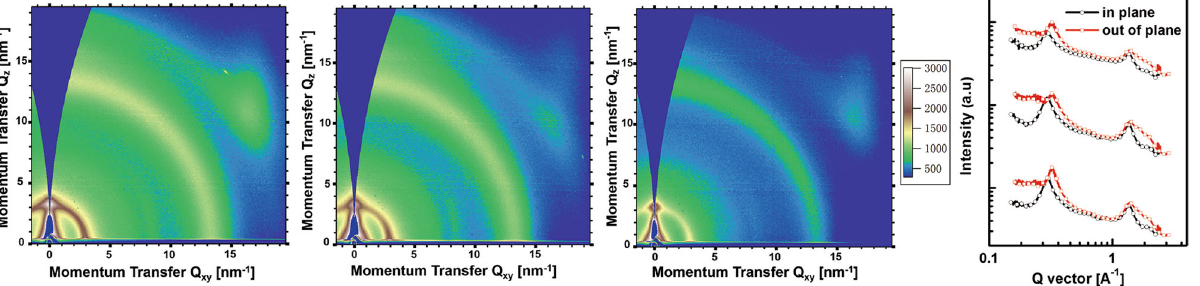
Fig. 3 2D GIWAXS patterns (from left to right: PTB7-Th M , PTB7-ThIr1 and PTB7-ThIr1.5) and scattering pro fi les (from bottom to up: PTB7-Th M , PTB7-ThIr1 and PTB7-ThIr1.5) of in-plane and out-of-plane directions for the corresponding polymer:PC 71 BM (1:1.5, w/w, with DIO) blended samples on a silicon substrate